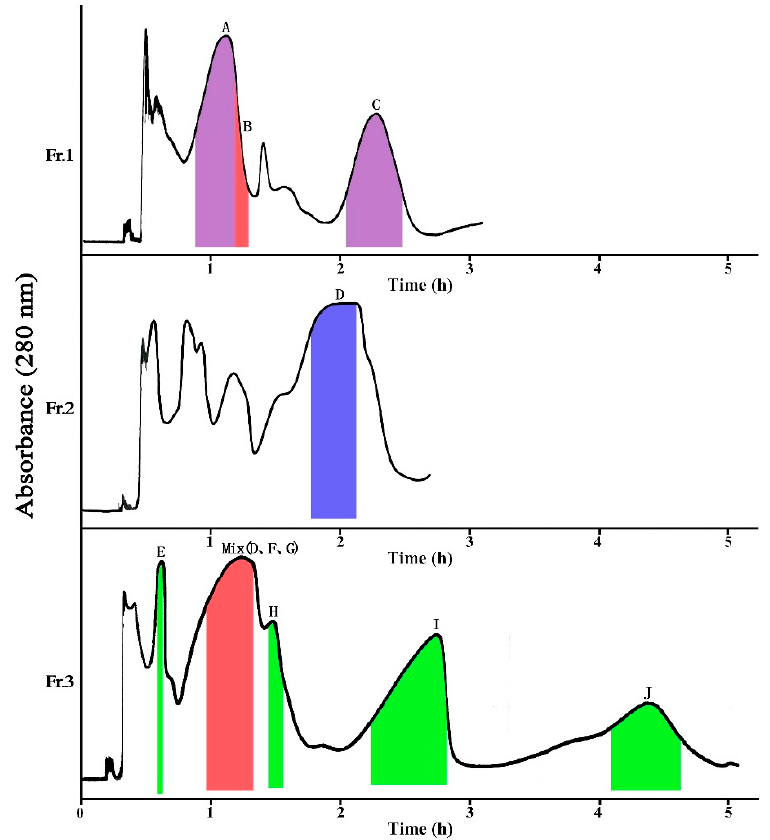
Figure 2. High-speed counter-current chromatography (HSCCC) chromatograms of Fr. 1–3. Compounds F and G were eluted as a